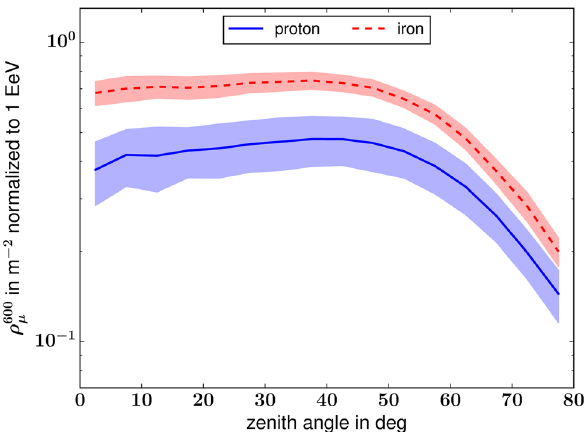
Fig. 5 Zenith angle dependence of the muon density at 600 m above a muon energy of 1 GeV. The muon density increases slightly for zenith